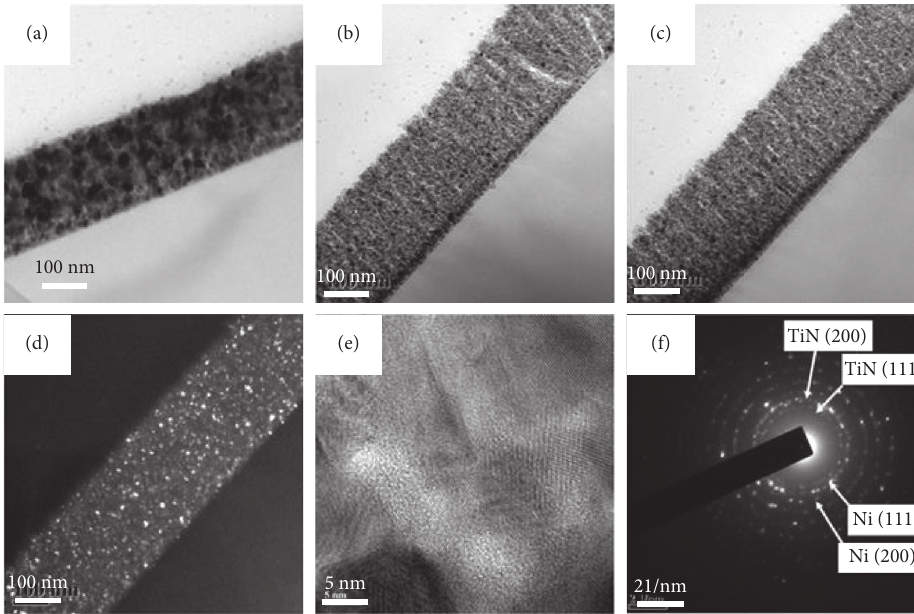
Figure 3: (a–c) BF-TEM images of Ni, Ni-TiN, and Ni 90 Cu 10 -TiN, (d) DF-TEM image of Ni 90 Cu 10 -TiN, (e) high-resolution image of Ni 90 Cu 10 -TiN, and (f) SAED pattern of